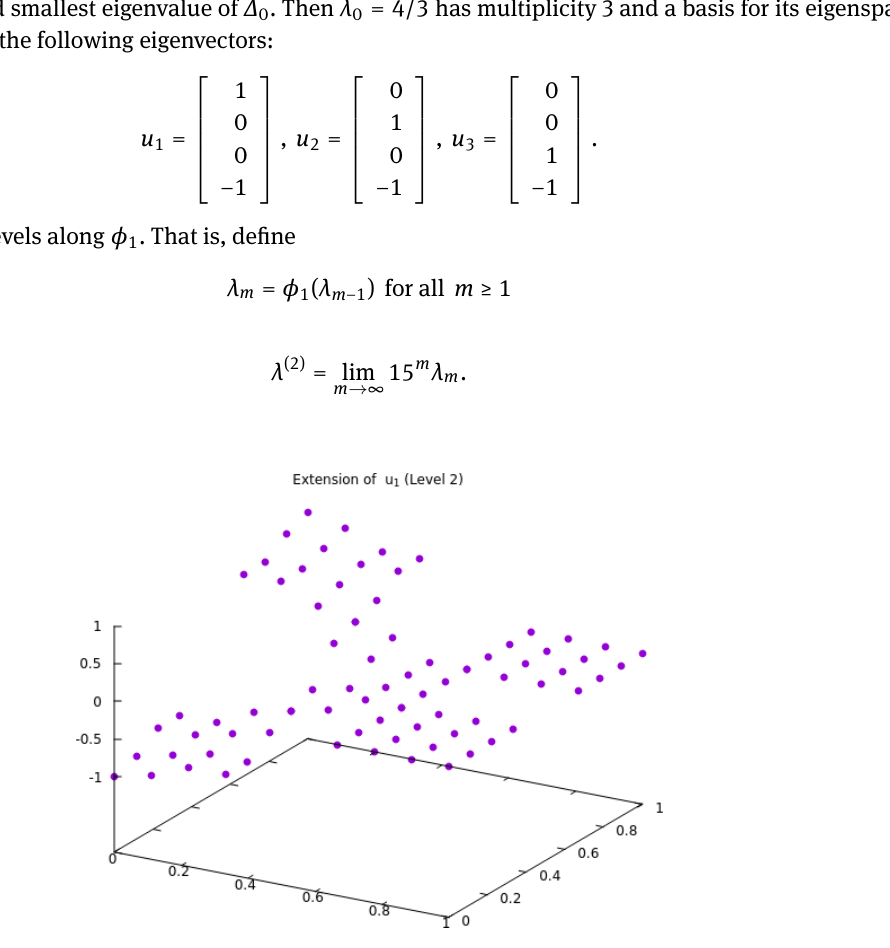
Figure 4: Extension of u 1 to V 2